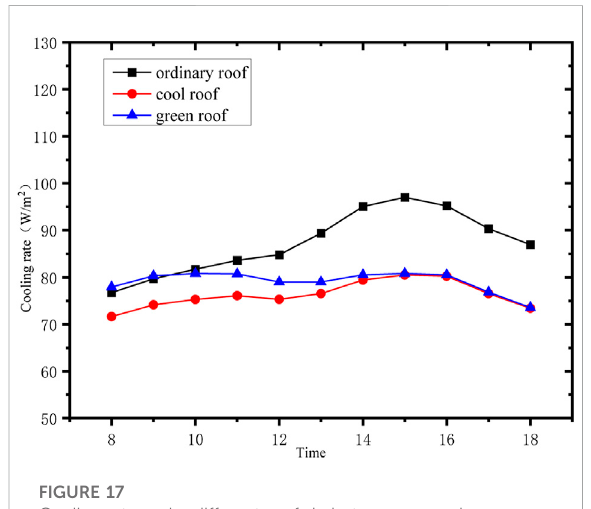
FIGURE 18 Whole day cooling load for hot summer and warm winter